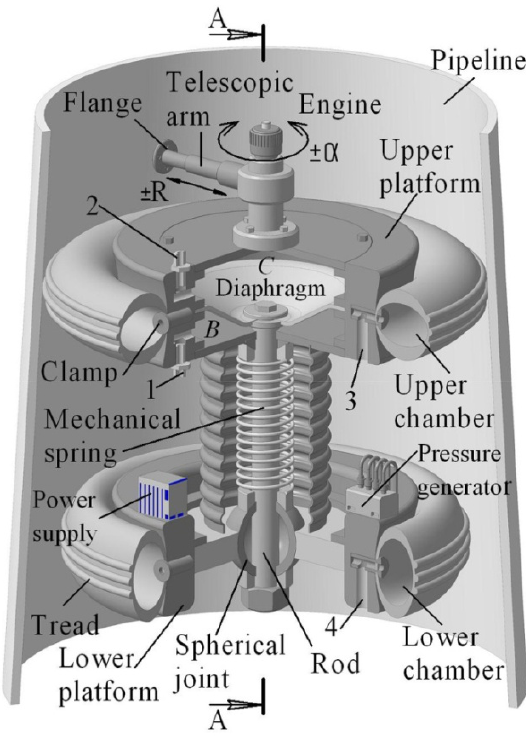
Figure 1. Mobile technological module in a quarter section To perform technological operations, a telescopic arm is installed on the upper platform, which extends by ±R and has a motor that rotates the arm through an angle of ± α . As shown in Figure 1, the telescopic arm flange is designed to accommodate various process equipment. Such equipment is determined by the type of technological operations, such as diagnostics of the internal state of pipes, their cleaning and application of protective coatings, machining, welding, and similar processes. The module's movement sequence inside the pipeline is shown in Figure 2. The distance between the upper and lower platforms is the dimension "A" in the initial position. When installing the module in a cylindrical or conical pipeline with a taper angle "ß," through channel 3 (see Figure 2, a), pressure is created (compressed air or liquid under pressure) in the upper elastic chamber of the upper platform. Under pressure, the upper chamber expands and fixes the module in the pipeline due to friction forces " F " and regular reaction forces " N ." This allows the module to overcome the gravitational load due to the force of the weight mg .